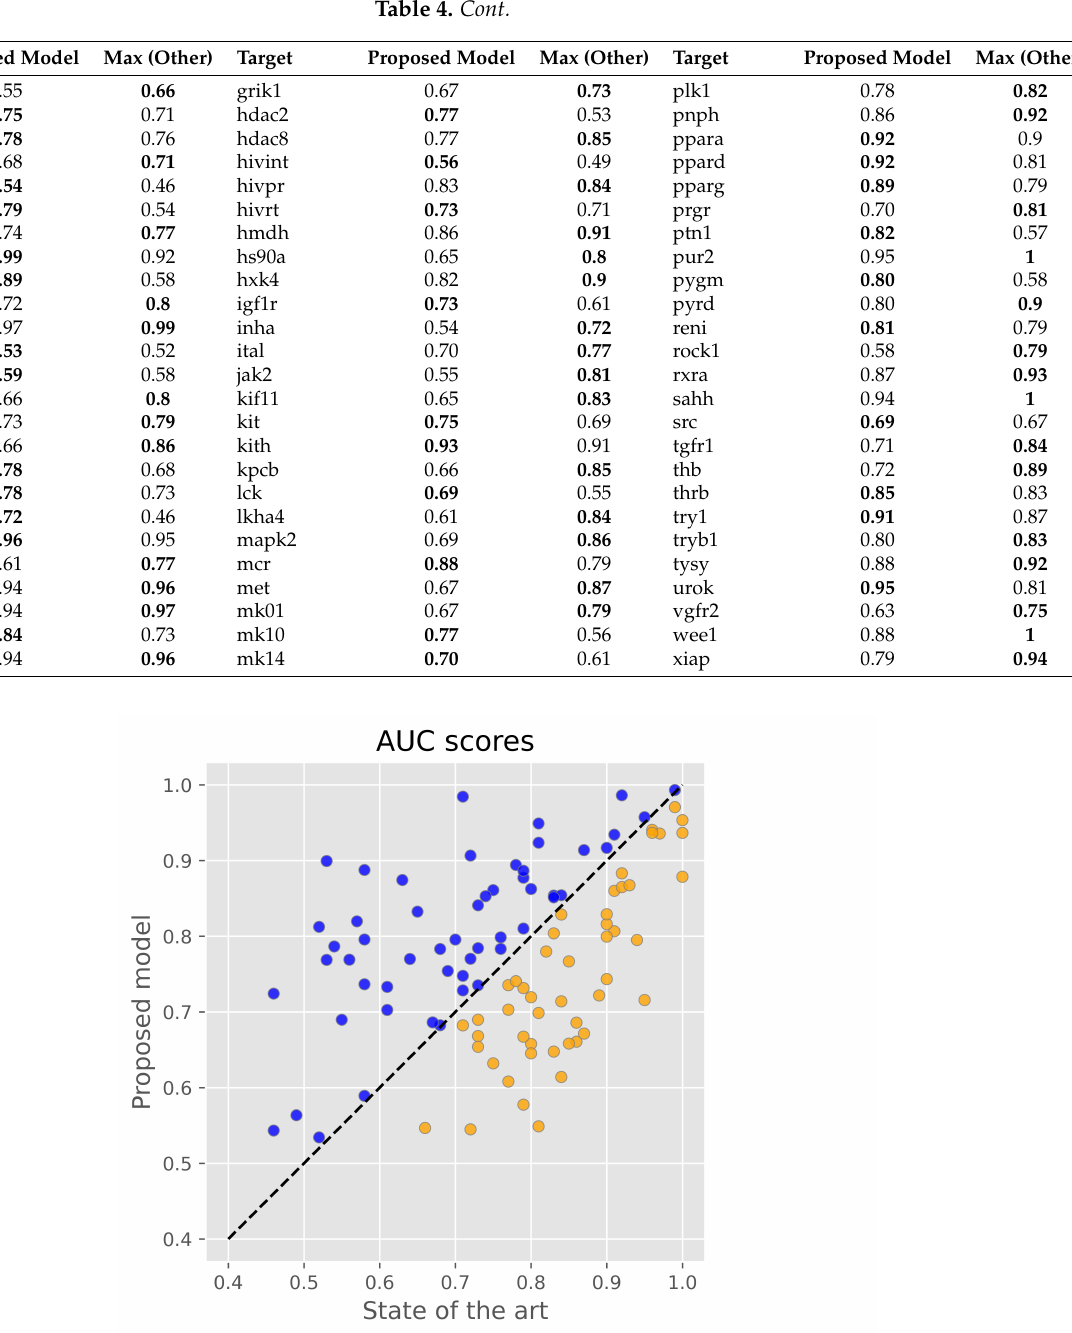
Figure 8. Visual representation of the scores shown in Table 4. Dots in blue indicate that the proposed VS system performs better; otherwise, we highlight the dots in orange